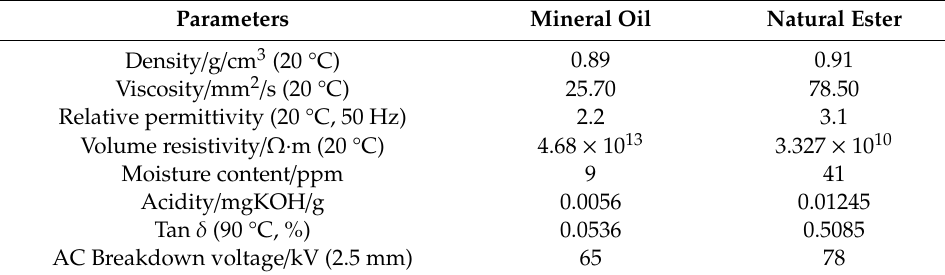
Table 1. Parameters of insulation oil.